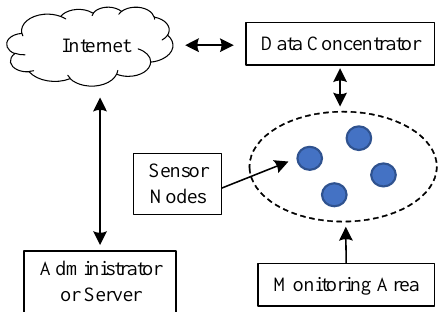
Figure 1. Topology of a wireless sensor network.